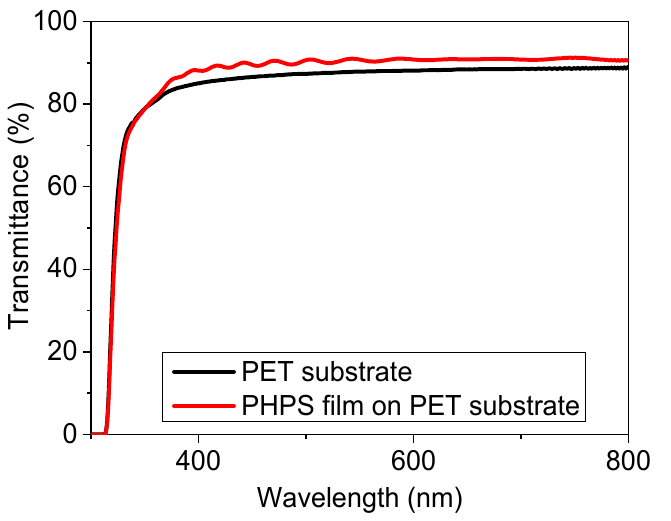
Figure 6. UV vis transmittance spectra of 3 layers of PHPS (each having thickness of ~700 nm) stacked on top of each other.